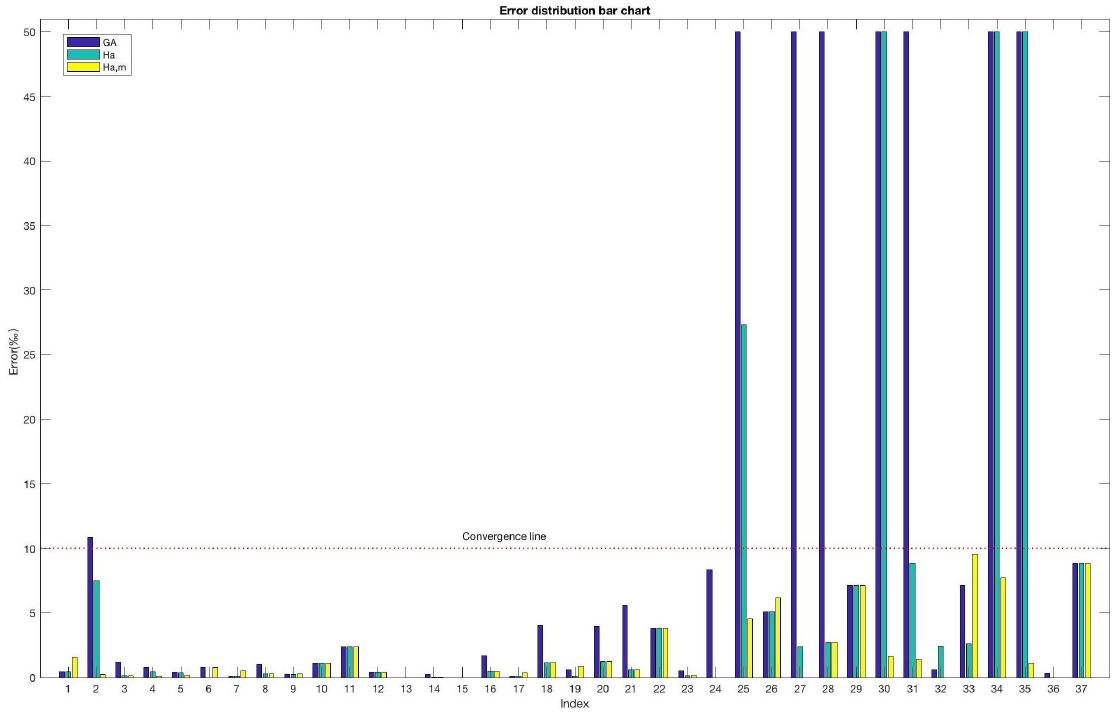
Figure 9. Error bar